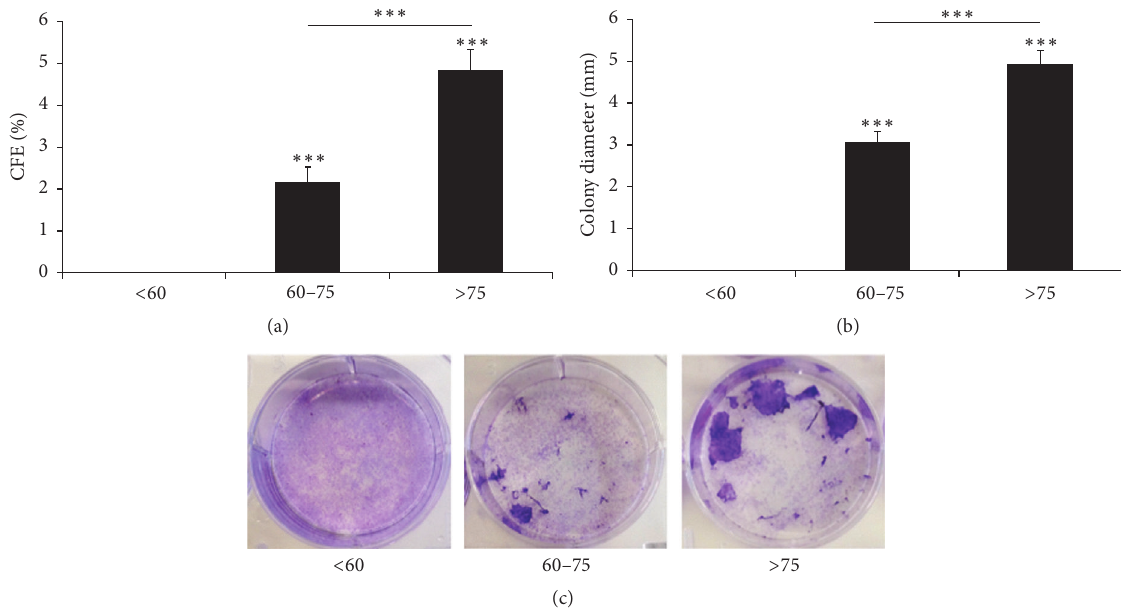
Figure 5: CFE with LSC pools. (a) Younger LSC donors did not show clones, and only 3T3 cells were seen as no washes were performed in this to prevent complete cell detachment. (b) Diameter of the colonies grown in (a): 𝑁 <60 = 0 , 𝑁 60 images. The results are presented as mean ± SE of 6 independent experiments. Statistical analysis was performed using two-tailed Student’s 𝑡 - test ( ∗∗∗ 𝑝 < 0.001 ).